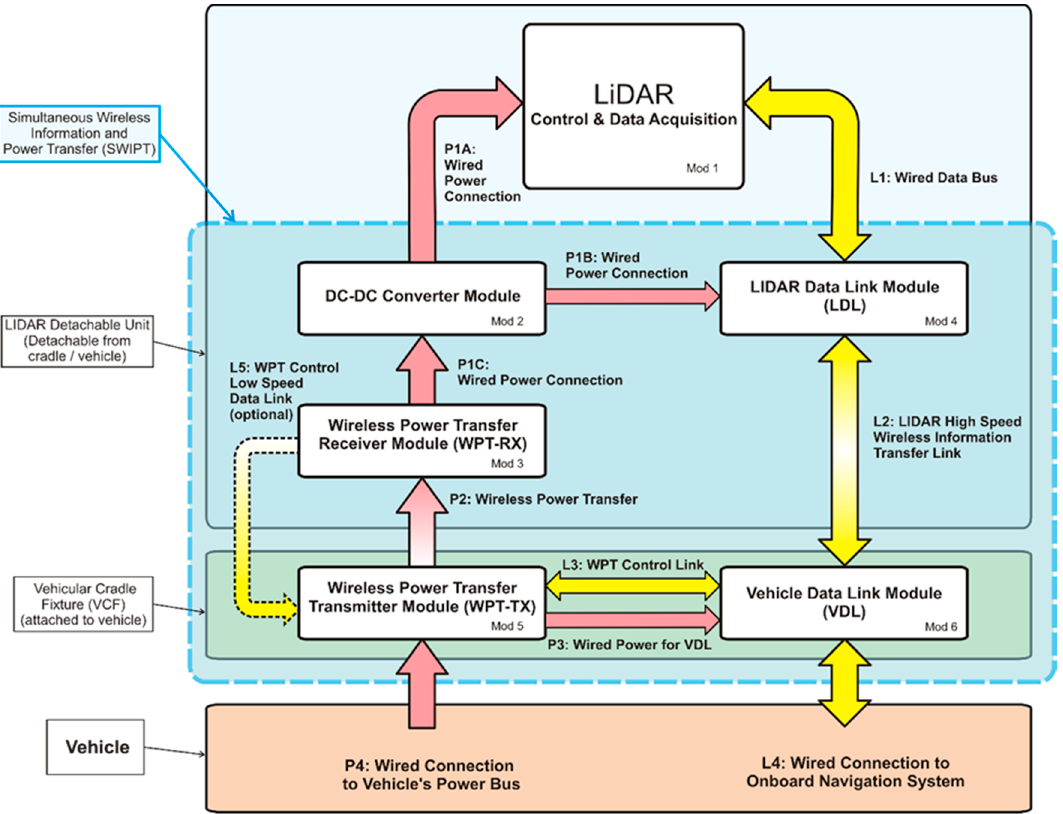
Figure 3. System architecture diagram, emphasizing wireless power transfer (WPT) implementation and wireless information transfer (WIT).